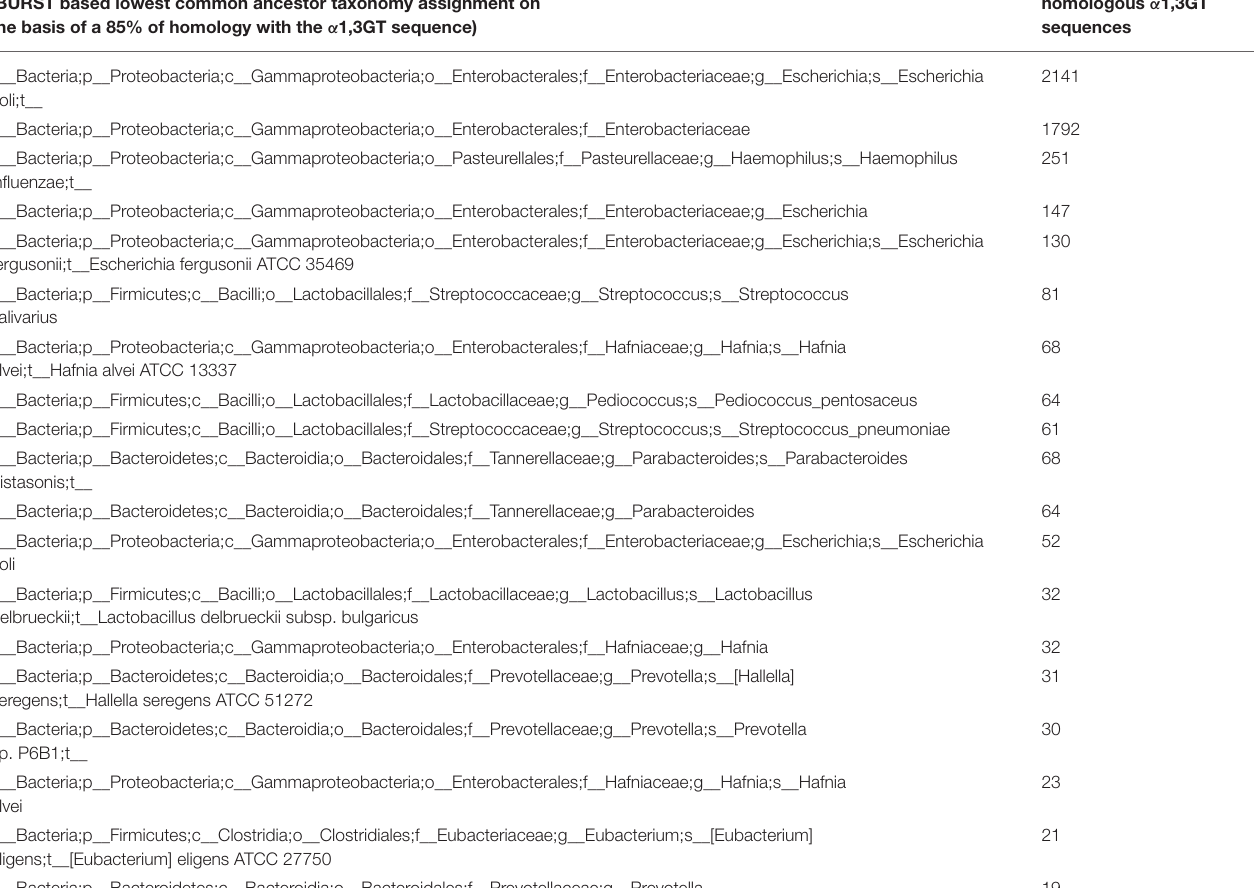
TABLE 1 | Most frequent hits for taxonomy. Taxonomy (BURST based lowest common ancestor taxonomy assignment on the basis of a 85% of homology with the α 1,3GT sequence)